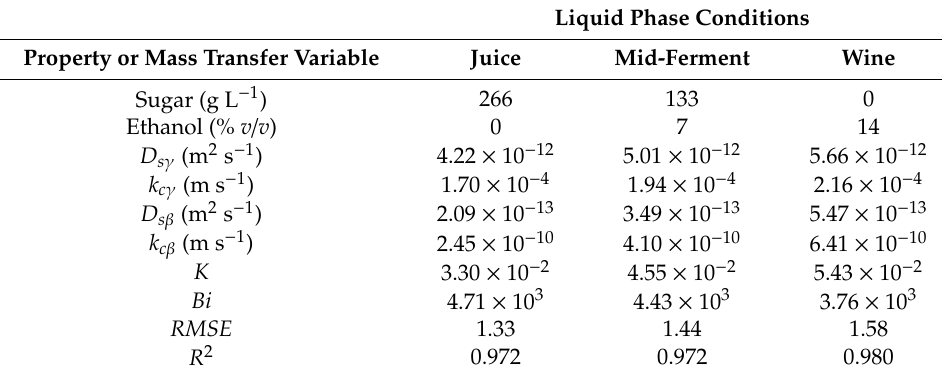
Figure 1. Experimental and fitted models under forced convection conditions for ( a ) solid phase depletion and ( b ) liquid phase accumulation of malvidin-3-glucoside. 266 g L − 1 sugar; (cid:78) , 133 g L − 1 sugar, and 7% v / v ethanol; (cid:95) , 14% v / v ethanol. Error bars represent the standard deviation across three replicates. Table 1. Summary of liquid phase conditions, mass transfer properties ( D s γ , k c γ , D s β , k c β , and K ), Biot number ( Bi ), and statistical parameters ( RMSE and R 2 ) for malvidin-3-glucoside solved using the method outlined in Section 3.2 for forced convective